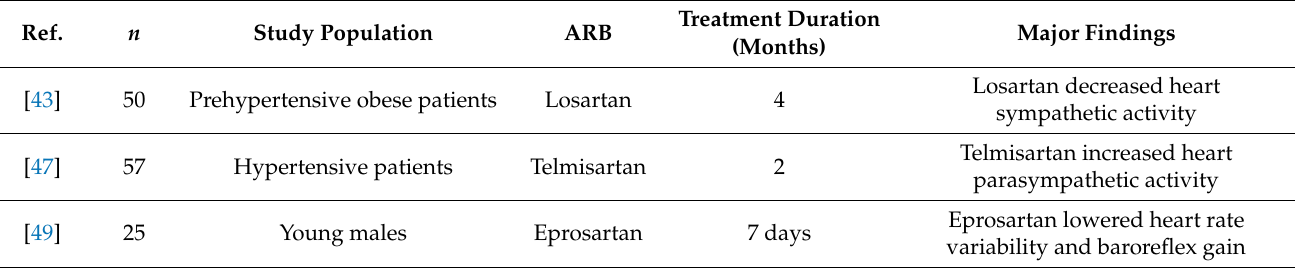
Table 3. Principal findings of major clinical studies that evaluated the effect of angiotensin receptor blockers (ARBs) on neuropathy in non-diabetic patients.